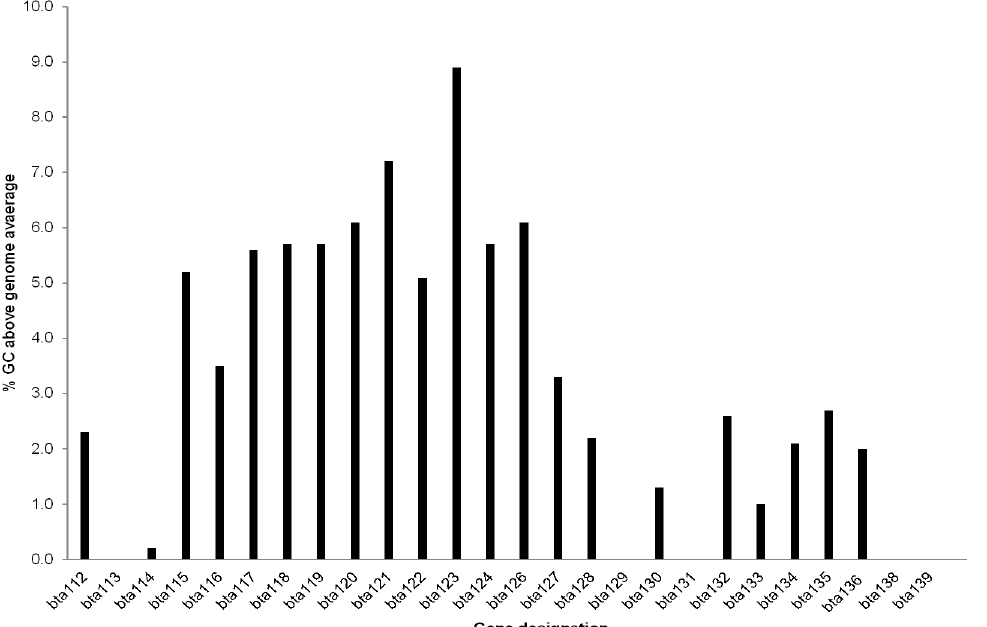
Fig 3. Percent increase of GC content of bta112 to bta139 compared to the B . turicatae genome. bta125 and bta137 were excluded from the analysis given the genes may be pseudogenes.